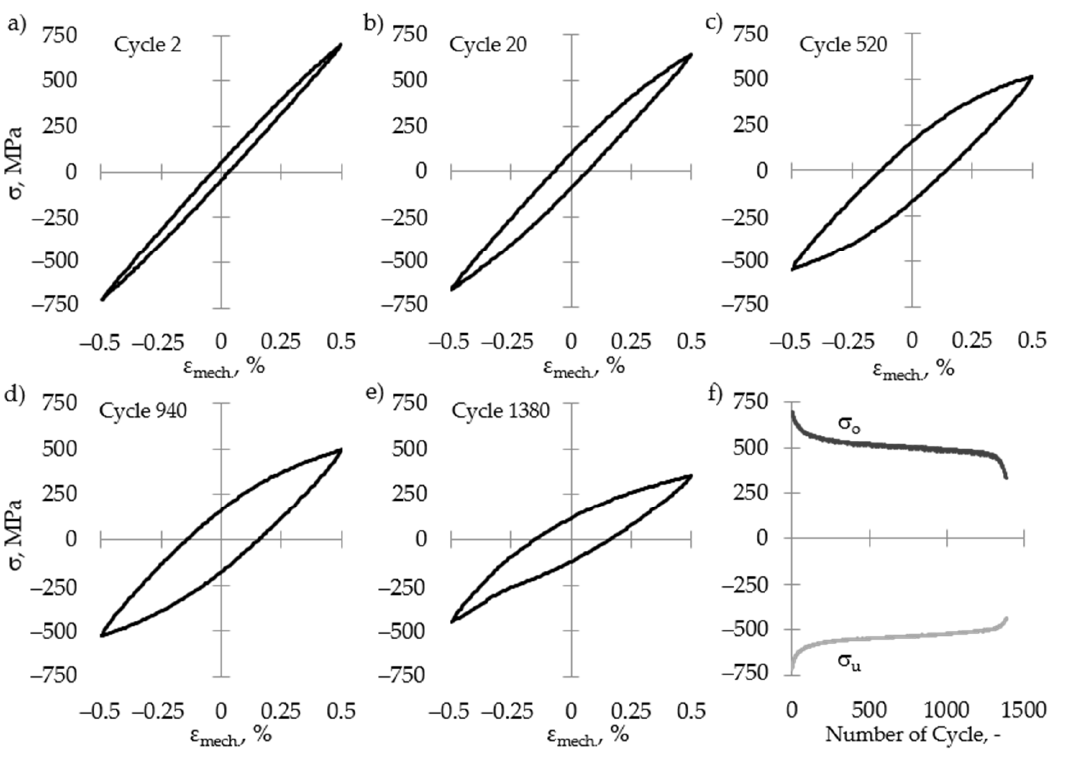
Figure 5. Stress−strain hysteresis loops after ( a ) 2 cycles, ( b ) 20 cycles, ( c ) 520 cycles, ( d ) 940 cycles, ( e ) 1380 cycles, and ( f ) maximum and minimum stress vs number of cycles for the fatigue test corresponding to Figure 4.